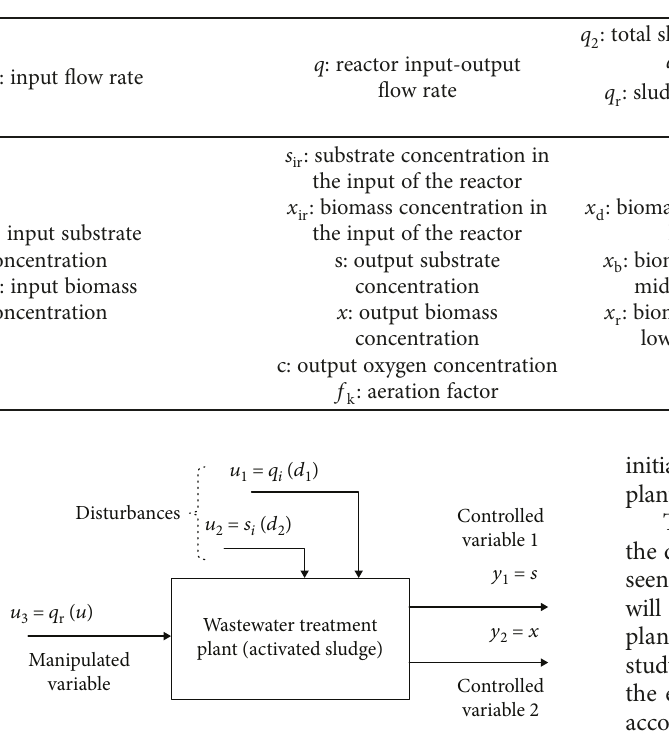
Figure 2: The multivariable nonlinear system considered.